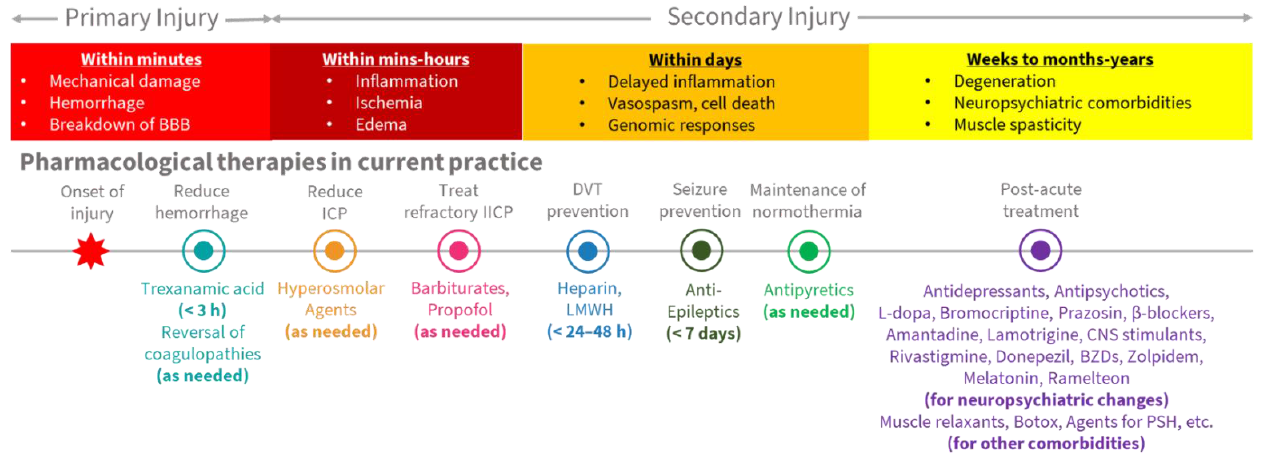
Figure 2. Alteration of CNS physiology and pharmacological therapies in TBI. Table 1. Current pharmaceutical therapies for TBI.